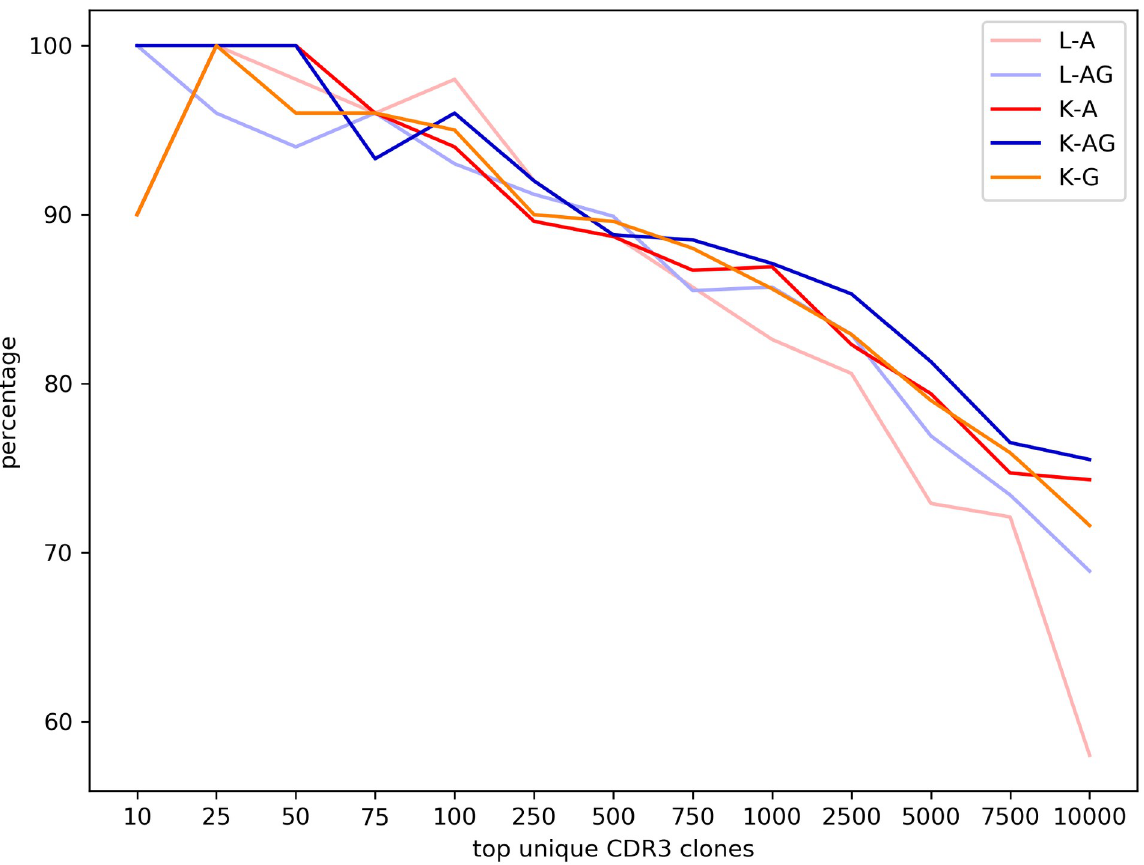
Fig 5. Percentage of common top unique CDR3 clones between two repeats of the five sets of 5’-RACE libraries.